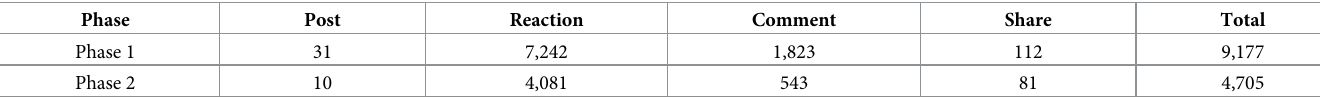
Table 4. Total of interactions that are related to the brand X in February